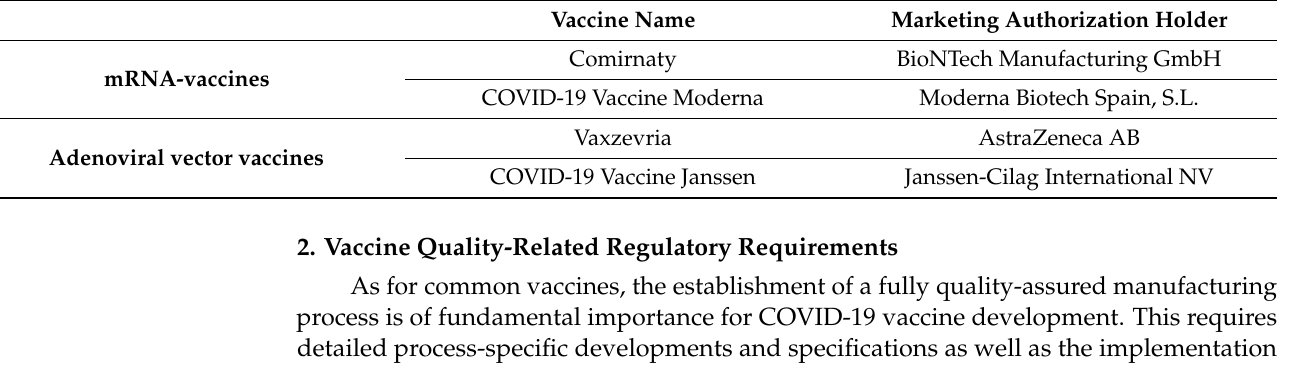
Table 1. COVID-19 vaccines licensed in the EU (as of 02 June